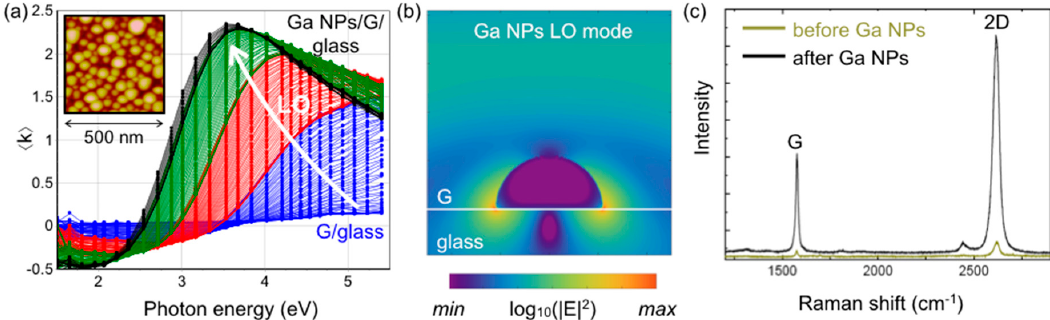
Figure 1. Ga nanoparticles (NPs) on G / glass substrate. ( a ) Extinction coe ffi cient spectra (cid:104) k (cid:105) recorded in Figure 1. Ga nanoparticles (NPs) on G/glass substrate. ( a ) Extinction coefficient spectra 〈 𝑘 〉 recorded 172 real time during Ga NP deposition on the G / glass substrate; the first blue spectrum refers to G / glass, in real time during Ga NP deposition on the G/glass substrate; the first blue spectrum refers to G/glass, 173 while the last black spectrum refers to the Ga NPs / G / glass; the arrow indicates Ga NP deposition. As an while the last black spectrum refers to the Ga NPs/G/glass; the arrow indicates Ga NP deposition. As 174 an inset is shown an atomic force microscopy (AFM) image of the Ga NP morphology. ( b ) Near-field 175 inset is shown an atomic force microscopy (AFM) image of the Ga NP morphology. ( b ) Near-field distribution of the electromagnetic field when the Ga NPs are excited at their longitudinal (LO) mode. 176 distribution of the electromagnetic field when the Ga NPs are excited at their longitudinal (LO) mode. ( c ) Raman spectra of the graphene layer/glass before and after Ga NP deposition. 177 ( c ) Raman spectra of the graphene layer / glass before and after Ga NP